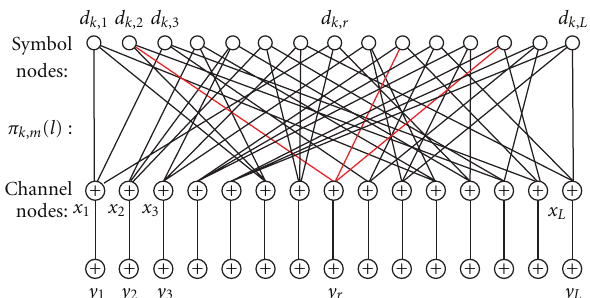
Figure 3: Signaling arrangement for the k th data stream. Symbols aggregating on the same channel node may use orthogonal signal waveforms. The actual received signal vectors y r are the superposition of K such data streams, causing the channel nodes to have large message